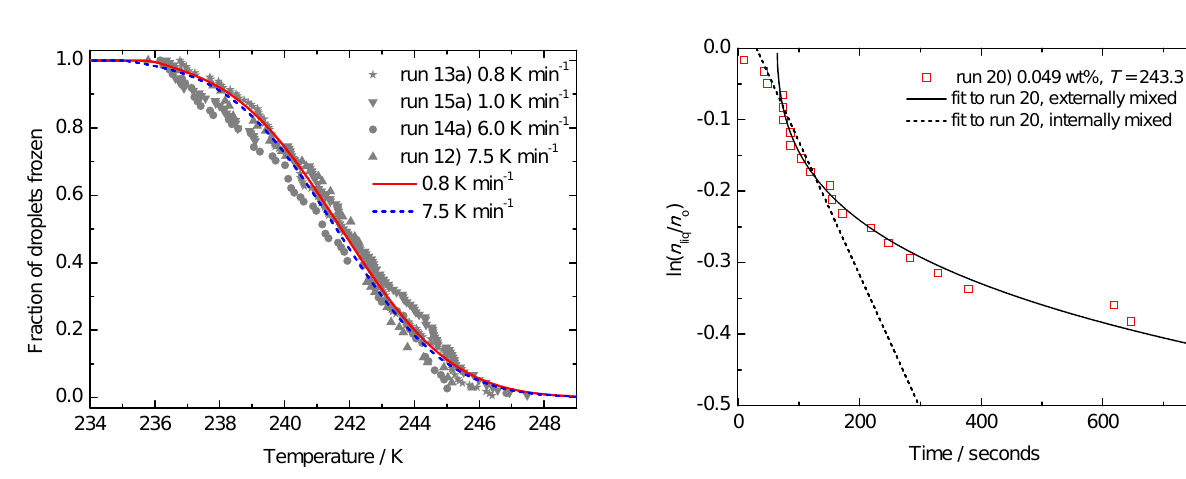
= 4.1 and for b = 10.1. We b